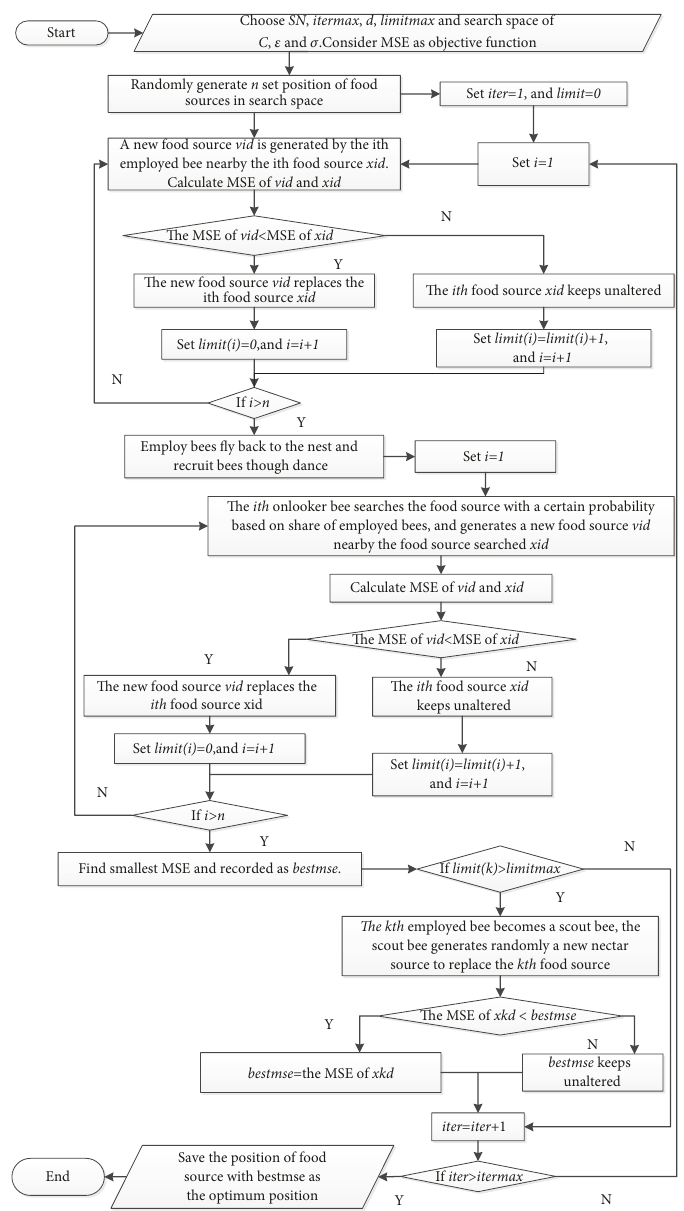
Figure 2: Flow chart for finding optimal combination of 𝐶 , 𝜀 , and 𝜎 through ABC algorithm by minimizing MSE of testing data.